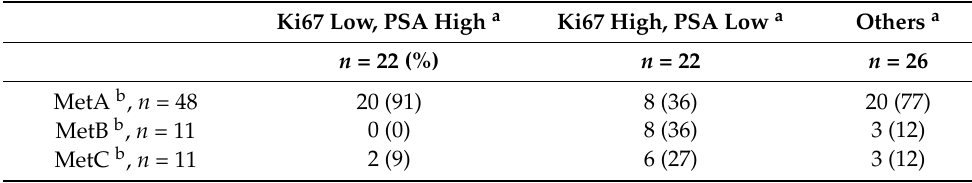
Table 5. Primary tumors differentiated based on combined immunostaining of the marker for proliferation Ki67 and prostate specific antigen (PSA), in relation to the transcriptomic metastasis subtypes MetA-C of paired bone